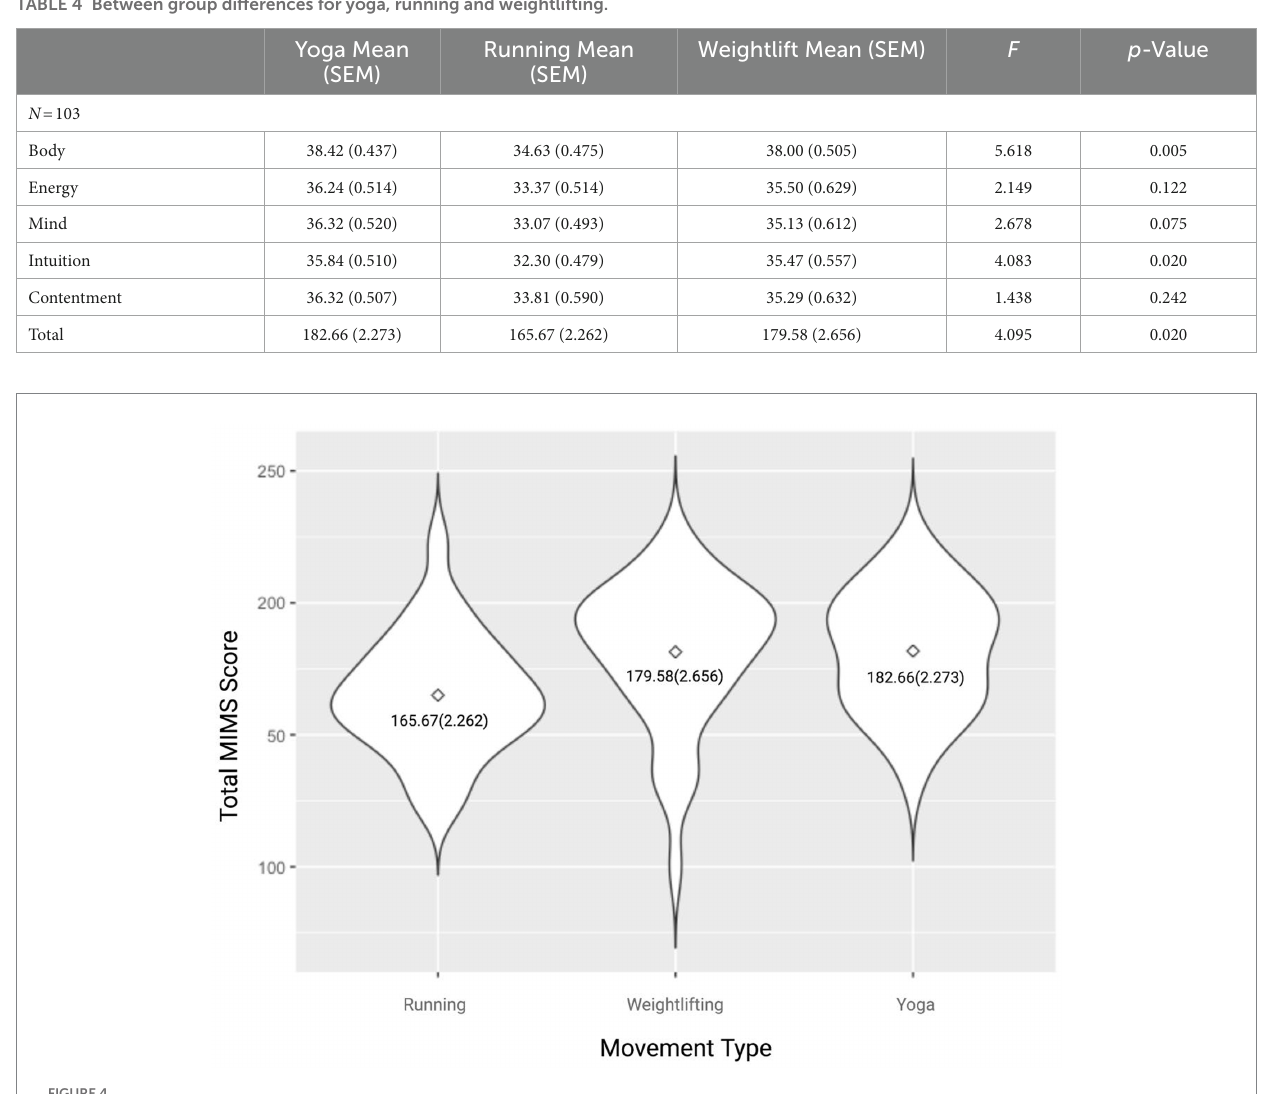
FIGURE 4 Violin plot of Total MIMS scores by movement group. Data reported as mean